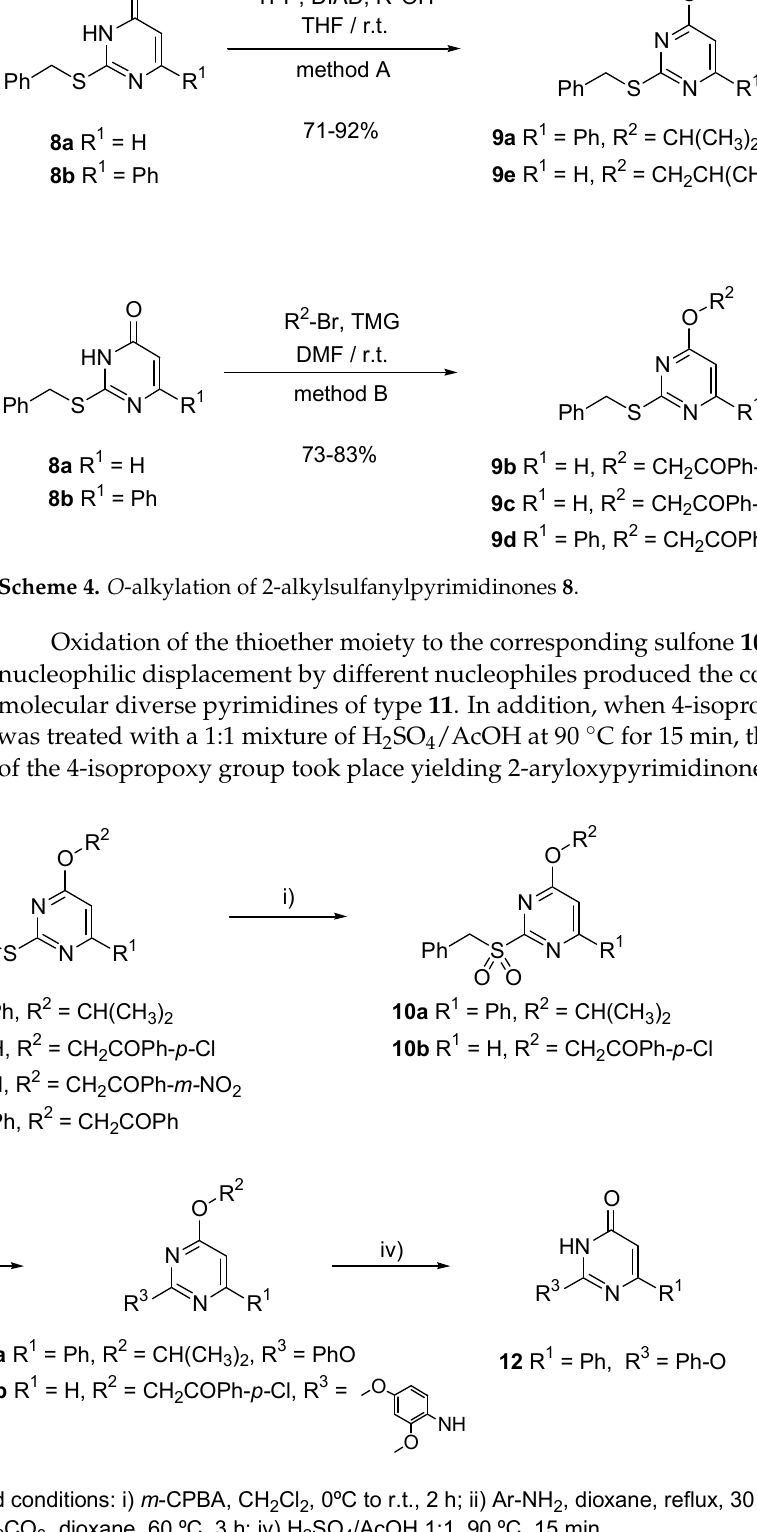
Scheme 5. Oxidation of 9 to the corresponding sulfone 10, nucleophilic displacement to produce the corresponding pyrimidines 11 , and displacement of the 4-isopropoxy group of 11a to yield 2-aryloxypyrimidinone 12